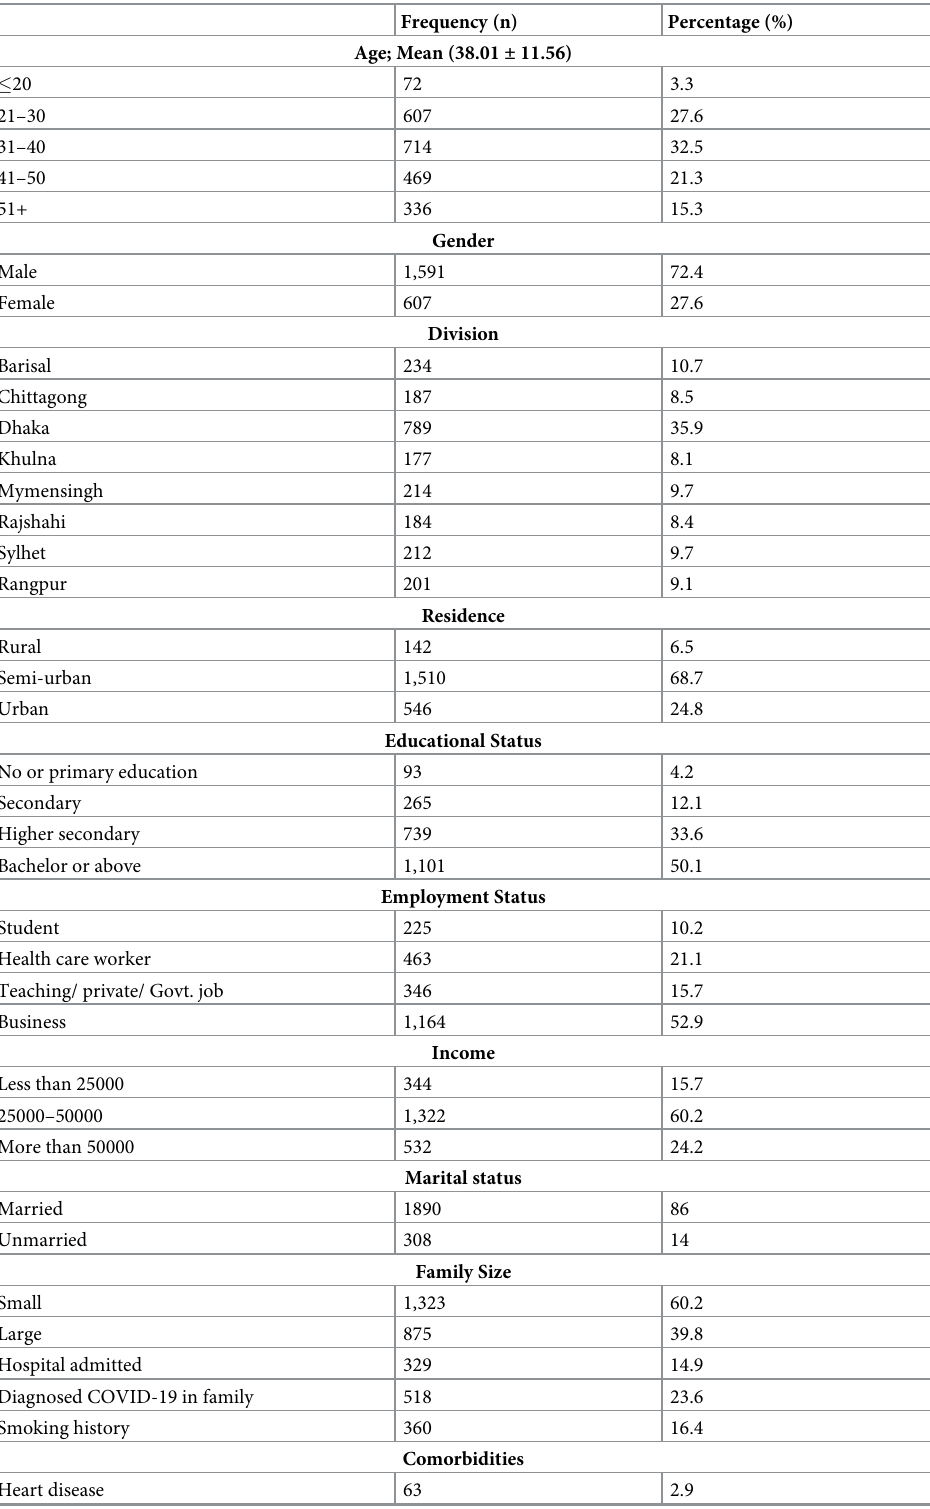
Table 1. Demographic, health situation and comorbidities characteristics of the analytic